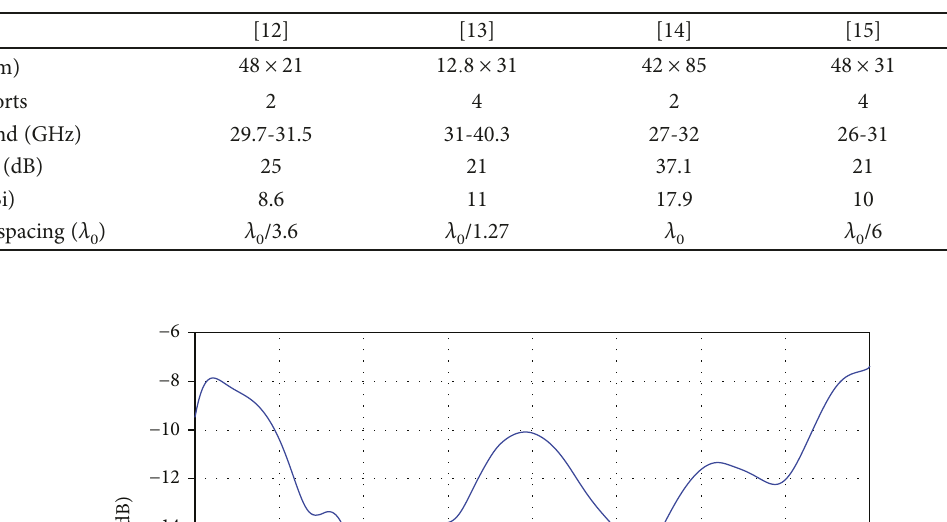
Table 2: Characteristic parameters of the typical antenna